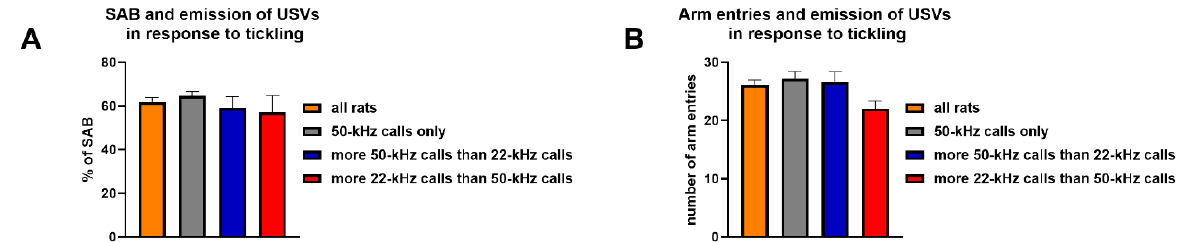
Figure 8. Percentages of spontaneous alternation behavior ( A ) and the number of entries in the arms of the Y maze ( B ) in rats grouped according to the prevalent type of ultrasonic vocalizations (i.e., 22-kHz or 50-kHz calls) emitted in response to tickling. SAB = spontaneous alternation behavior; USVs = ultrasonic vocalizations. n = 40 for the groups “all rats”; n = 21 for the groups “50-kHz calls only”; n = 12 for the groups “more 50-kHz calls than 22-kHz calls”; n = 7 for the groups “more 22-kHz calls than 50-kHz calls”.